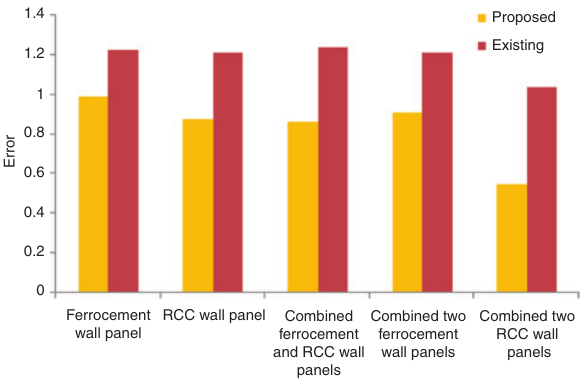
Figure 3: Comparison Graph.